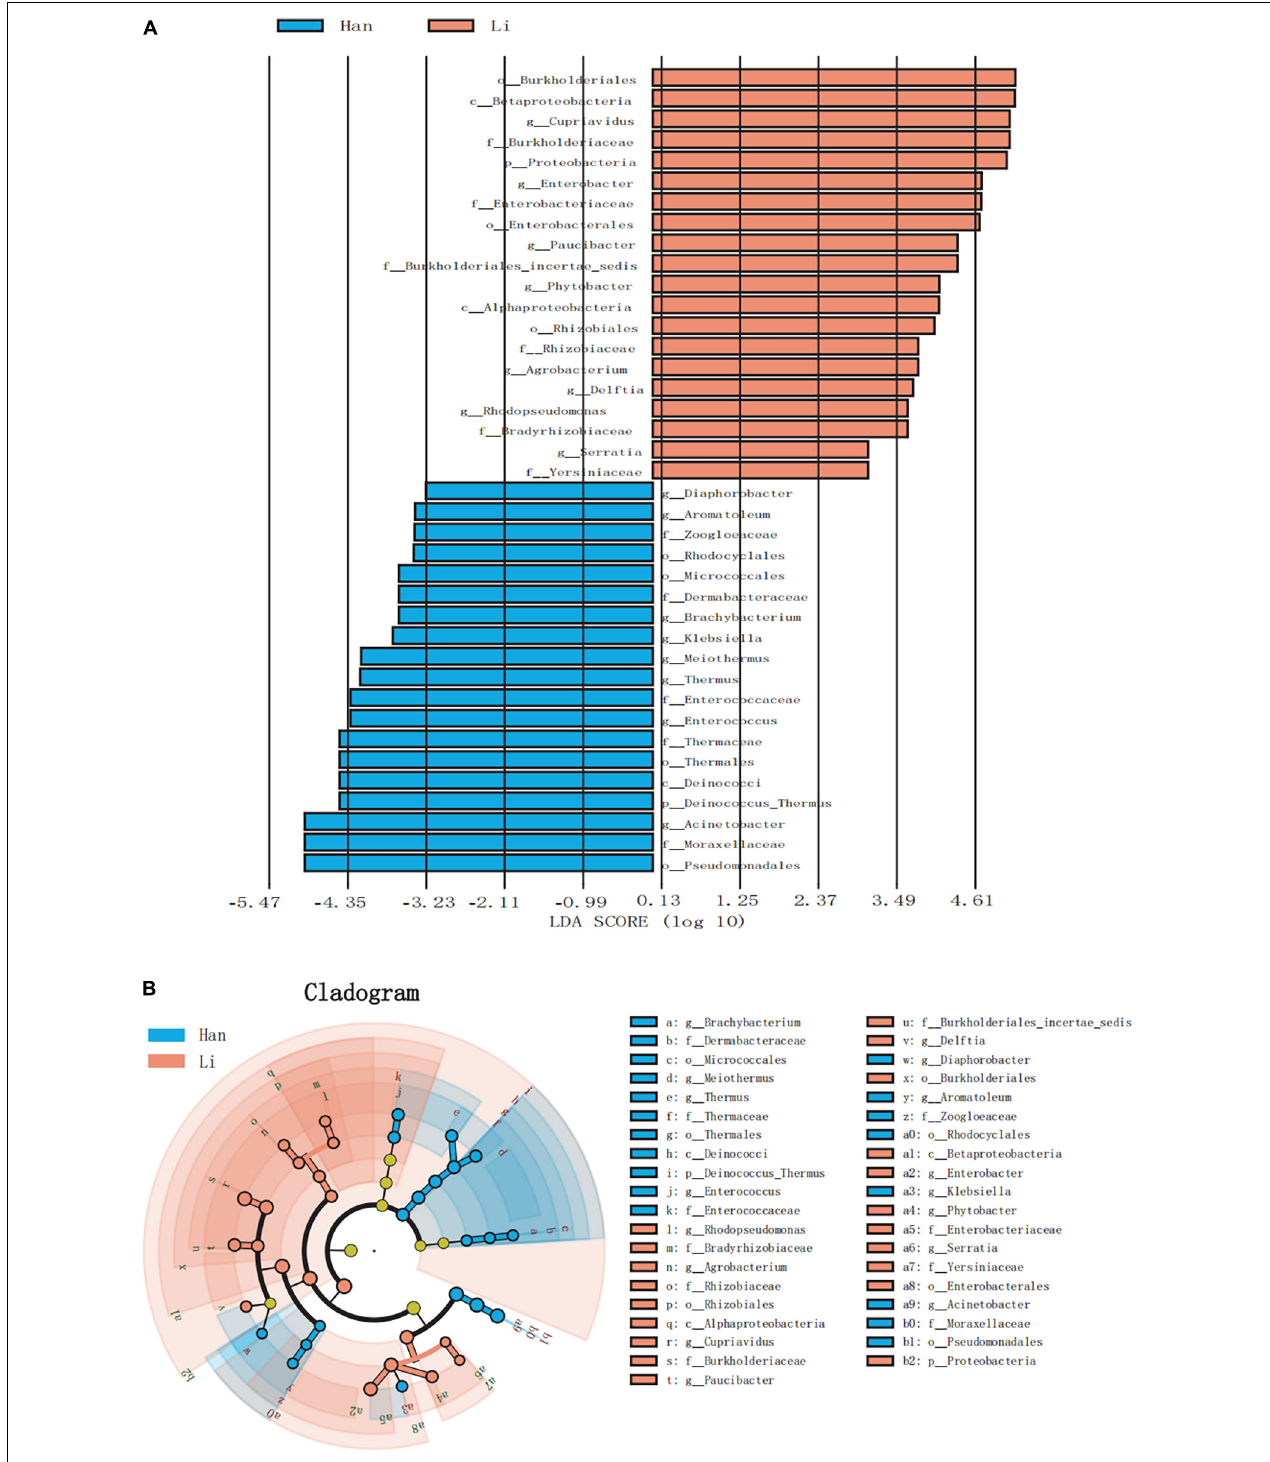
FIGURE 4 | LEfSe based on bacterial communities in colostrum samples from two different ethnic groups. (A) Histogram of LDA value distribution (LDA score > 3.0). (B) LEfSe analysis evolutionary branch diagram.